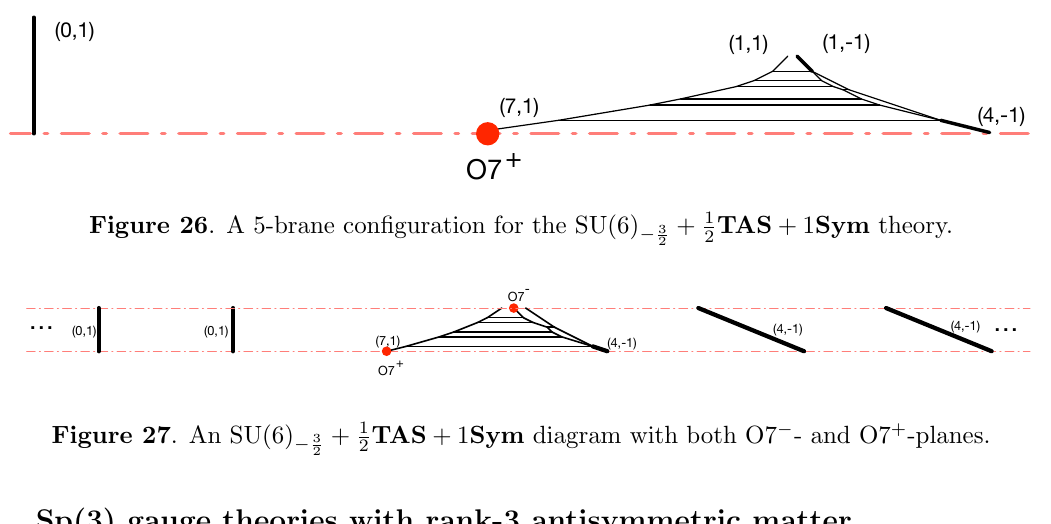
Figure 27 . An SU(6)